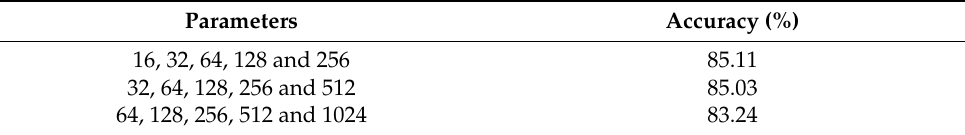
Table 9. The channels’ number of the feature-maps